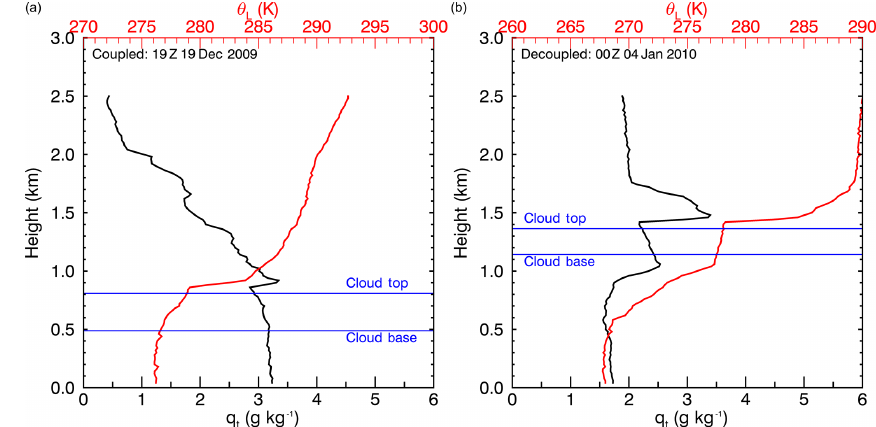
Figure 1. Vertical profiles of liquid water potential temperature ( θ L ) and total water mixing ratio ( q t ) for coupled (a) and decoupled (b) boundary-layer conditions. Blue lines denote cloud top and base heights, respectively.